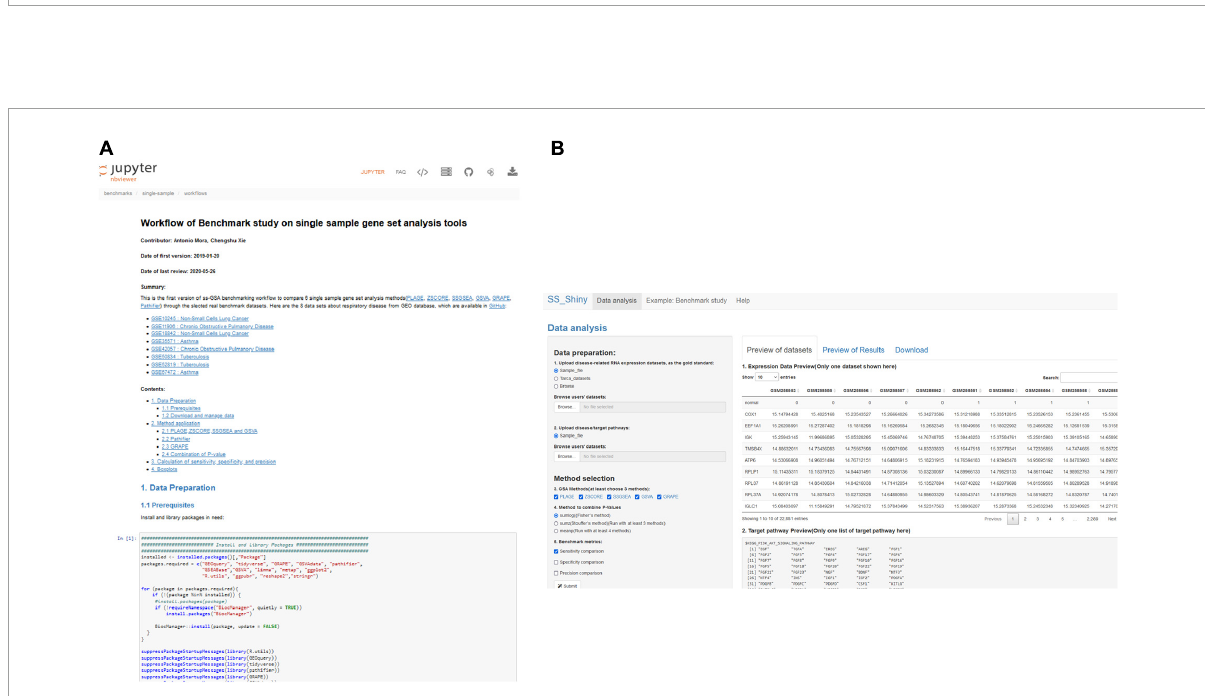
FIGURE5 GSA BenchmarKING screenshot. (A) A jupyter notebook with an R workflow for the benchmark of six different single-sample GSA tools using datasets related to respiratory disease. (B) A shiny app to benchmark five different single-sample GSA tools using different gold standards, target pathways, and benchmark